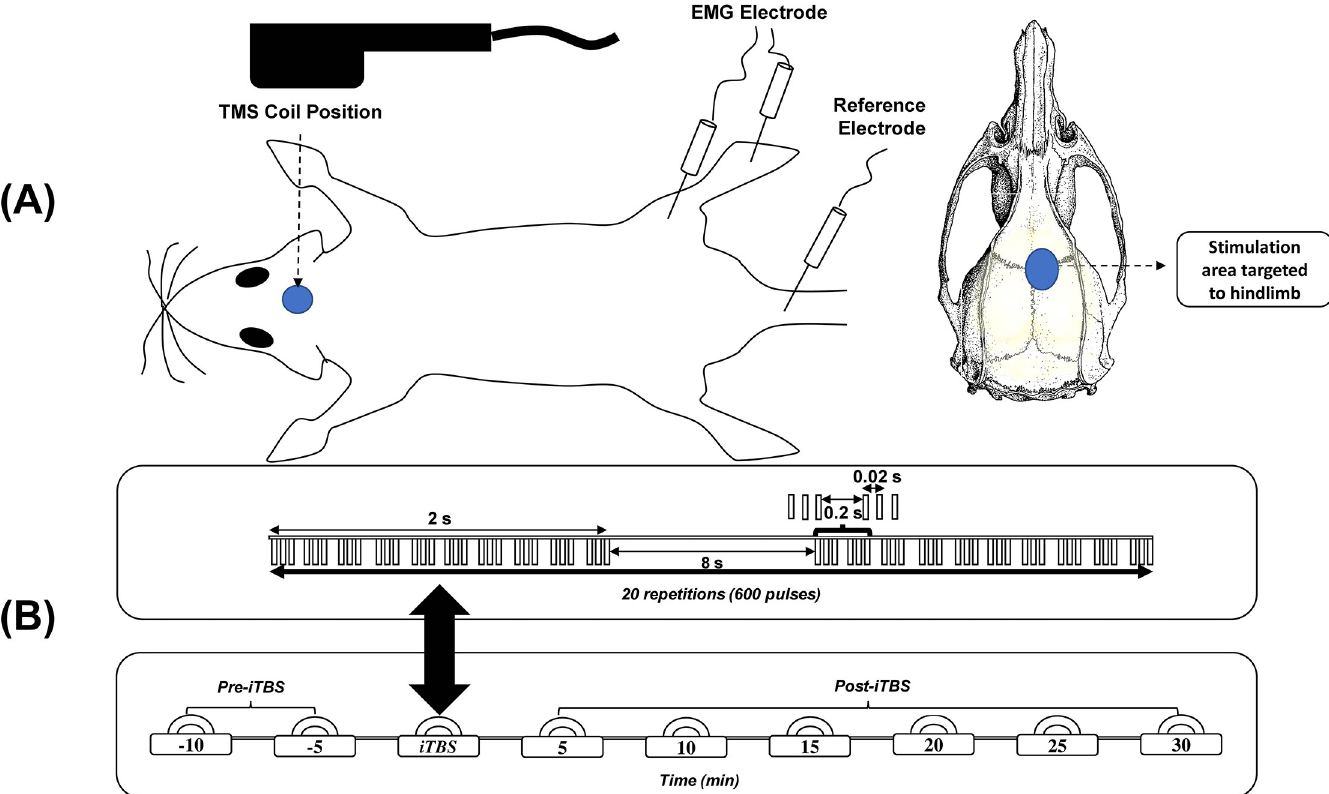
Fig 2. Protocol for motor-evoked potential (MEP) measurements. Placement of the transcranial magnetic stimulation coil and electrodes to record MEPs from rat models (A). Intermittent theta-burst stimulation (iTBS) consisted of 600 pulses that burst within 192 s; 15 MEPs were recorded every 5 min twice before iTBS and six times after iTBS